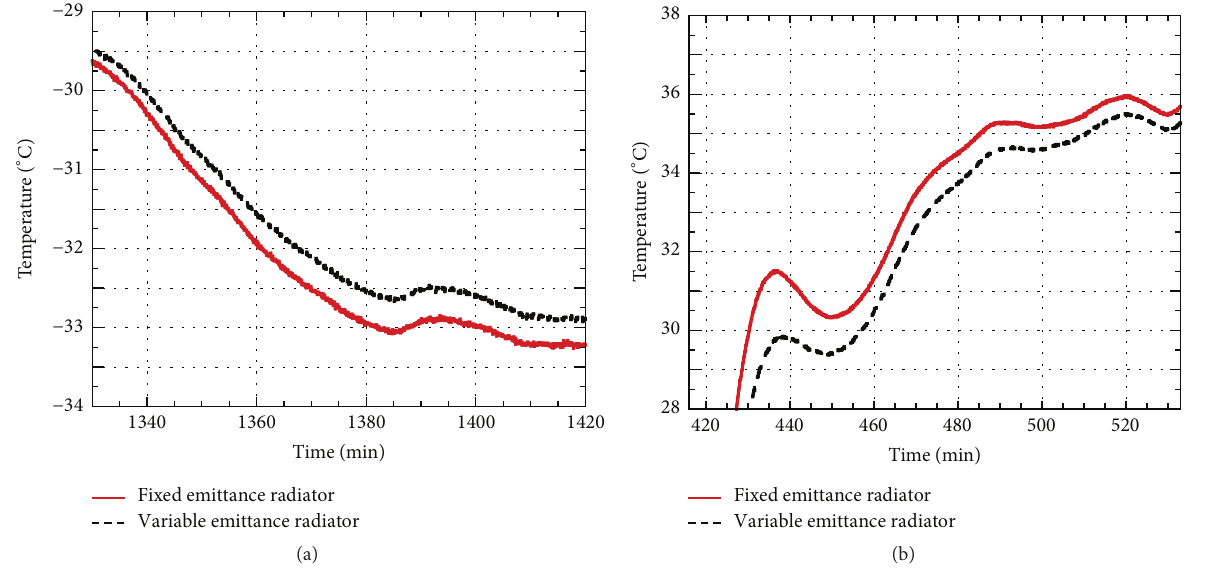
Figure 17: Temperature profiles of the VER and EFR ((a) transition to cold test phase, (b) transition to hot test phase).